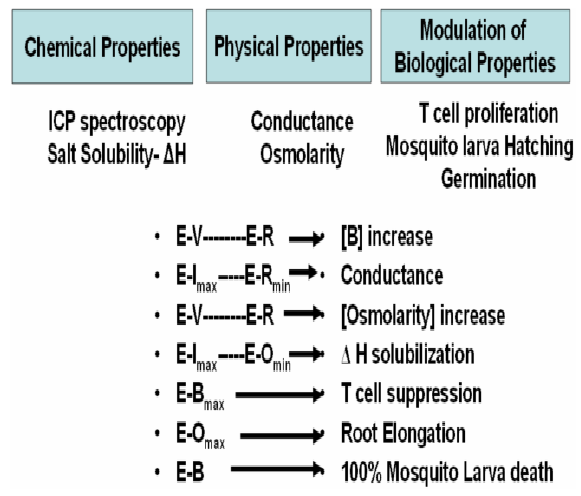
Figure 7: Maximum changes in properties of water as specific wavelength